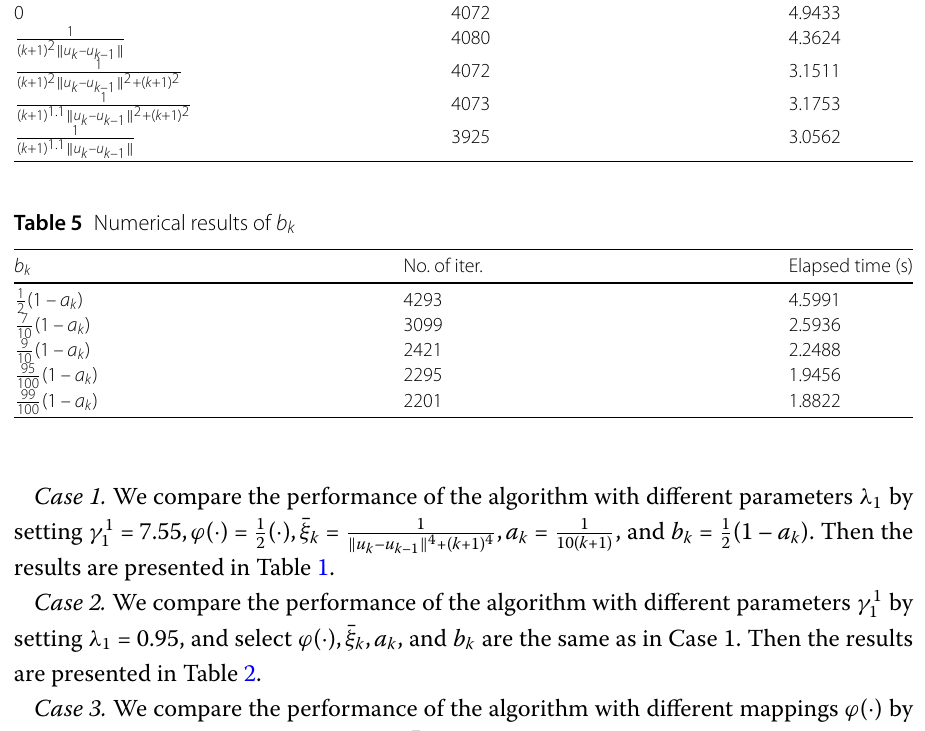
Table 4 Numerical results of